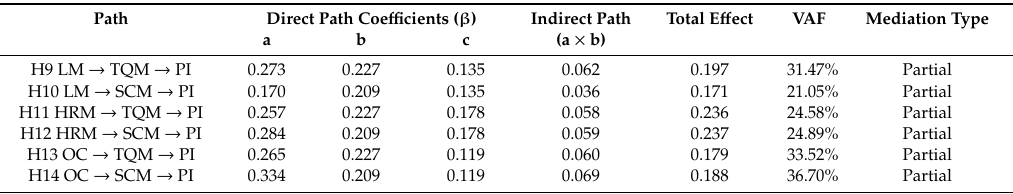
Table 6. The results for mediating e ff